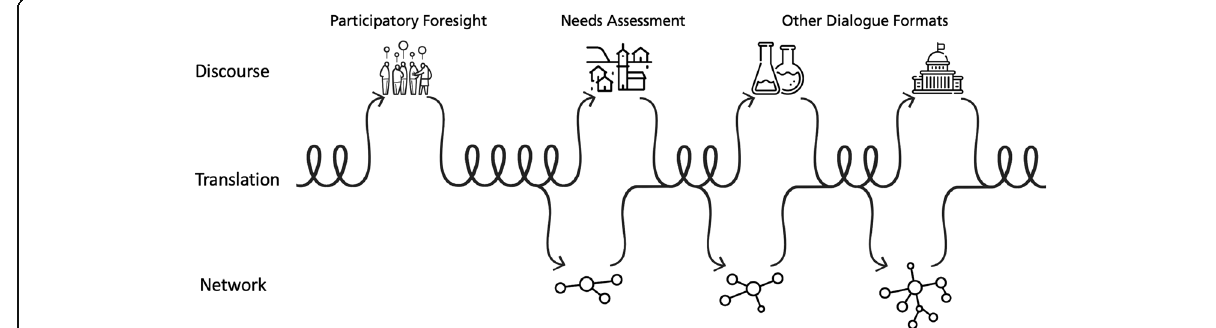
Fig. 1 Process map of the participatory agenda setting process within the “ Broadening horizons — changing perspectives ” project © Fraunhofer